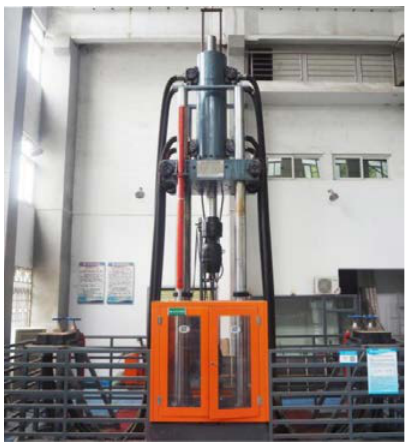
Figure 2. Electric hydraulic tensile impact test machine.